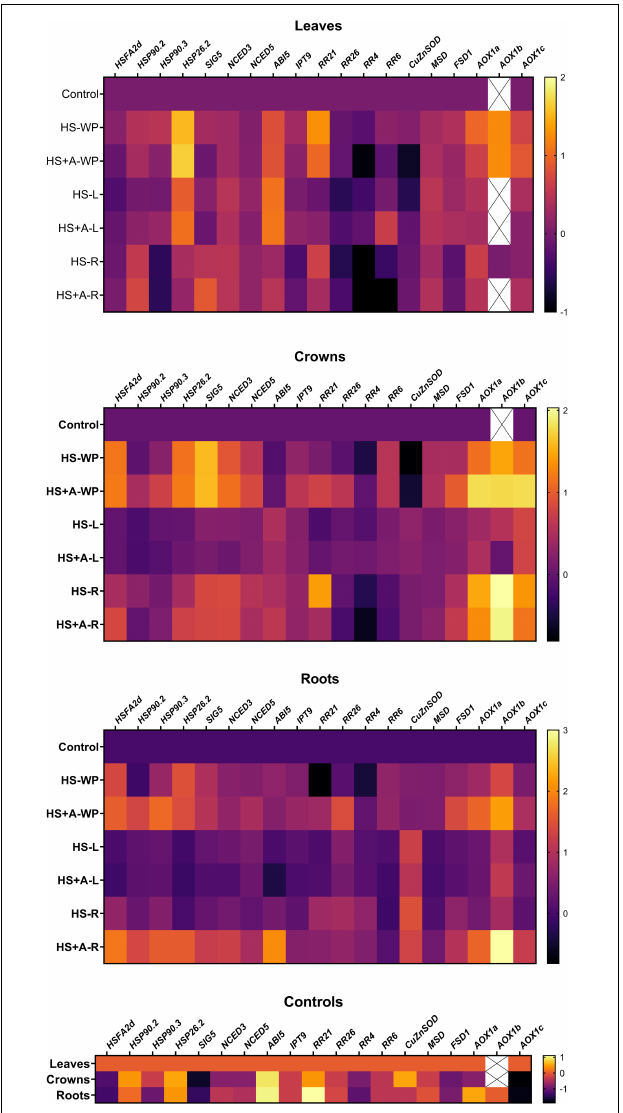
FIGURE 10 | The activity of superoxide dismutase (SOD) in leaves, crowns and roots of rice seedlings exposed to heat stress directly (HS) or after acclimation (HS + A). Heat stress was applied to whole plants (HS-WP), to leaves (HS-L), or to roots (HS-R). Data are means ± SD. One-way ANOVA with Tukey’s post hoc test ( p < 0.05, n = 3) was used to compare controls to the HS treatments. Significant differences compared to control plants are indicated by asterisks ( ∗ ) while crosses (+) indicate significant differences between HS and HS + A